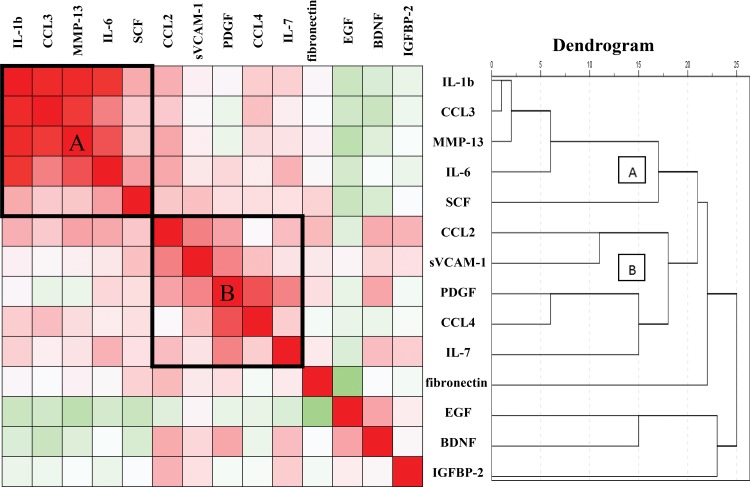
Cluster analysis.Heat map of hierarchical cluster analysis of the serum levels of cytokines, chemokines, growth factors and tissue remodeling factors in the relatives. Color-coded correlation matrix illustrates Pearson’s correlation coefficients. Significant positive correlations are given in the red scale (darkest red are correlation coefficients > 0.50), and significant negative correlations are given in the (dark) green scale. Lighter fields are not significant. In addition, a dendrogram is presented as a result of the hierarchical clustering. A indicates cluster A and B indicates cluster B.